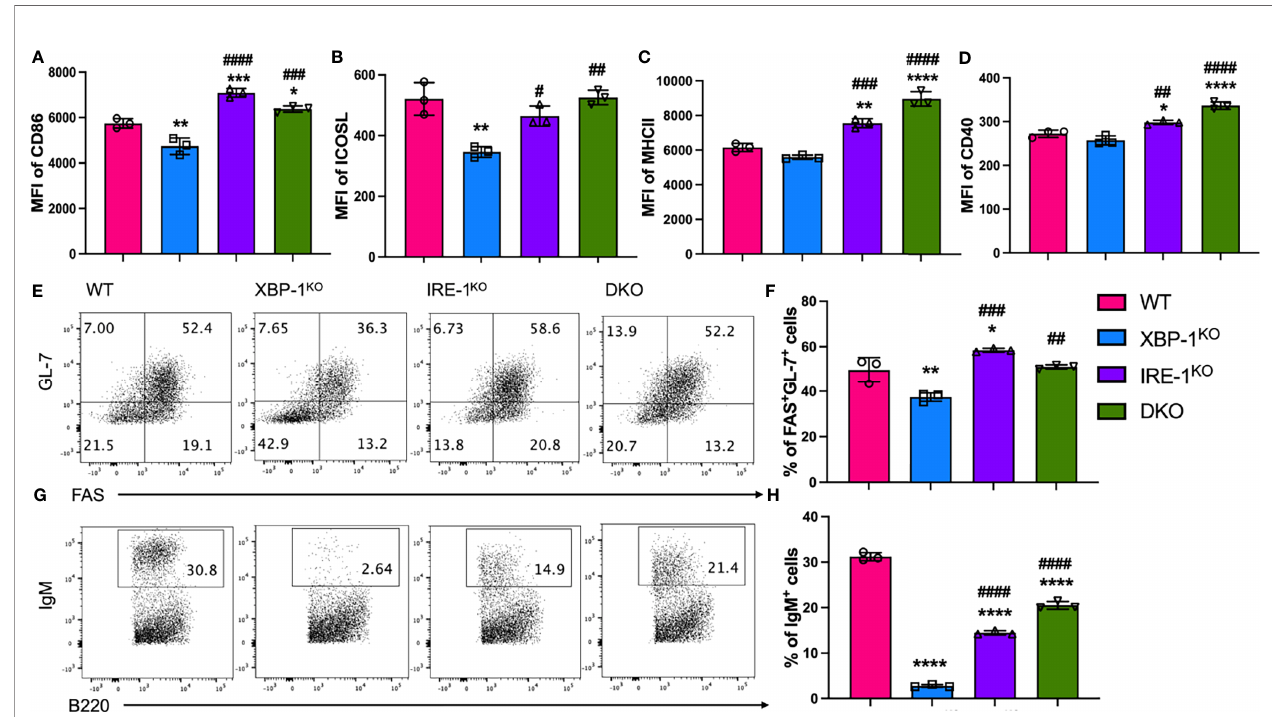
FIGURE 1 | Roles of XBP-1s and IRE-1 a in B cell activation, differentiation and IgM production in vitro . B cells were isolated from WT, XBP-1 KO , IRE-1 a KO , and IRE- 1 a KO /XBP-1 KO (double KO; DKO) mice and stimulated with 1 mu;g/ml LPS and 10 ng/ml IL-4 for 4 days. The cell surface expression levels of CD86 (A) , ICOSL (B) , MHCII (C) , and CD40 (D) were measured by fl ow cytometry analysis. Germinal Center B cells (FAS + GL-7 + ) were detected by fl ow cytometry (E, F) . B cells were stimulated with PMA and Ionomycin for another 4 hrs. B cells were intracellularly stained and analyzed for IgM production (G, H) . Data are representative graphs and fl ow cytometry plots of three independently repeated experiments. Data are shown as means ± SD. MFI, mean fl uorescence intensity. Statistics were performed using ordinary one-way ANOVA with Tukey ’ s multiple comparison test. *p < 0.05, **p < 0.005, ***p < 0.0005, and ****p < 0.0001 when compared to WT. # p < 0.05, ## p < 0.005, ### p < 0.0005, and #### p < 0.0001 when compared to XBP-1 KO